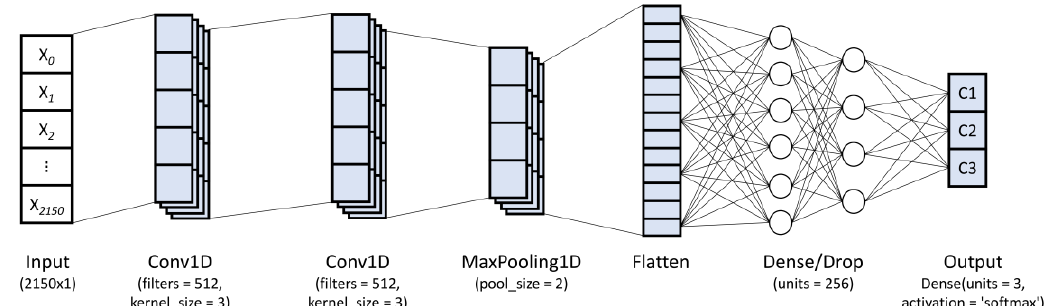
Figure 2. A schematic representation of the proposed Conv1D model architecture.